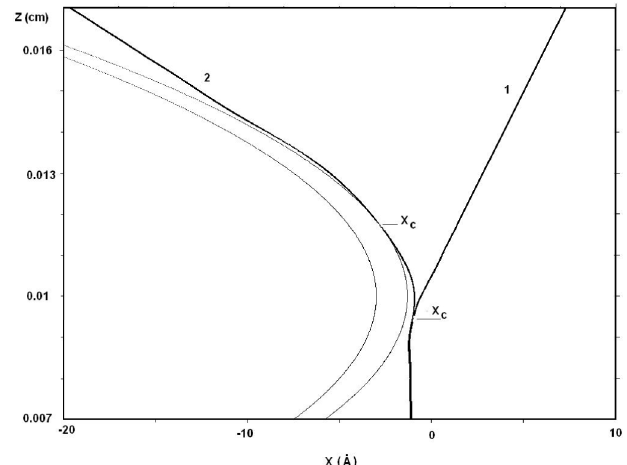
FIG. 5. The picture of volume reflection in a bent single crystal with R (cid:5) 1 m and (cid:4) (cid:5) 100 (cid:7) rad . Curves 1 and 2 correspond to maximal absolute values of (cid:5) (positive and negative, respec- tively). For visualization, this figure is shown in a turned (on (cid:4) ) coordinate system, or, in other words, the z -axis of the new coordinate system is directed along the initial particle velocity. The two ellipses present the location of atoms in a bent single crystal. The elliptic form is due to the difference in scales along x and z axes.